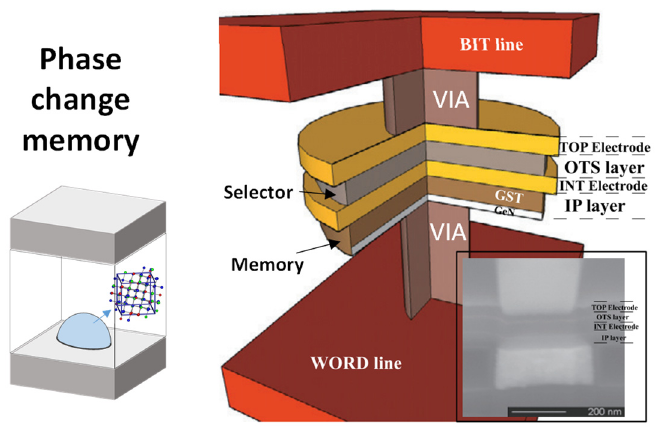
Figure 3. 3D schematics and SEM cross section of a GeSbTe (GST) phase change memory integrated with GeSeSbN OTS selector from [71].